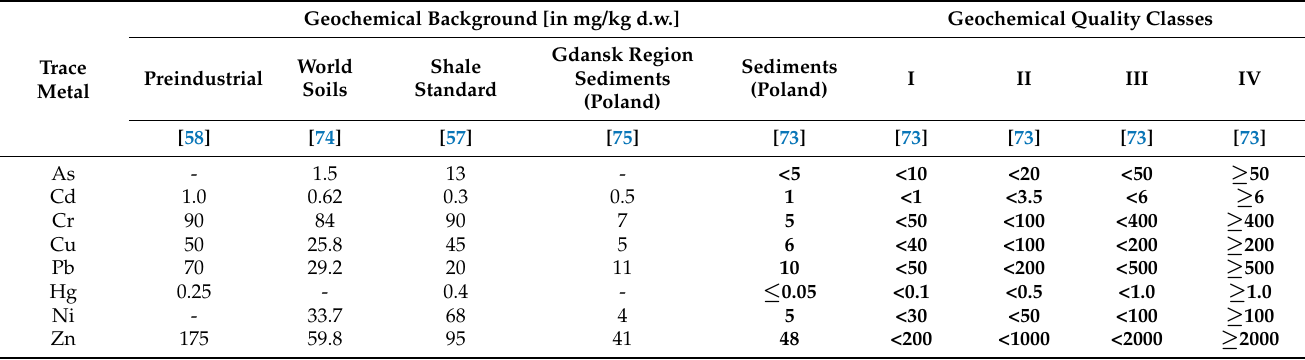
Table 1. The concentration of various trace metals (TMs) in mg/kg d.w. for each class of sediments—geochemical classification of aquatic sediments [57,58,73–75]. Geochemical Background [in mg/kg Trace Metal